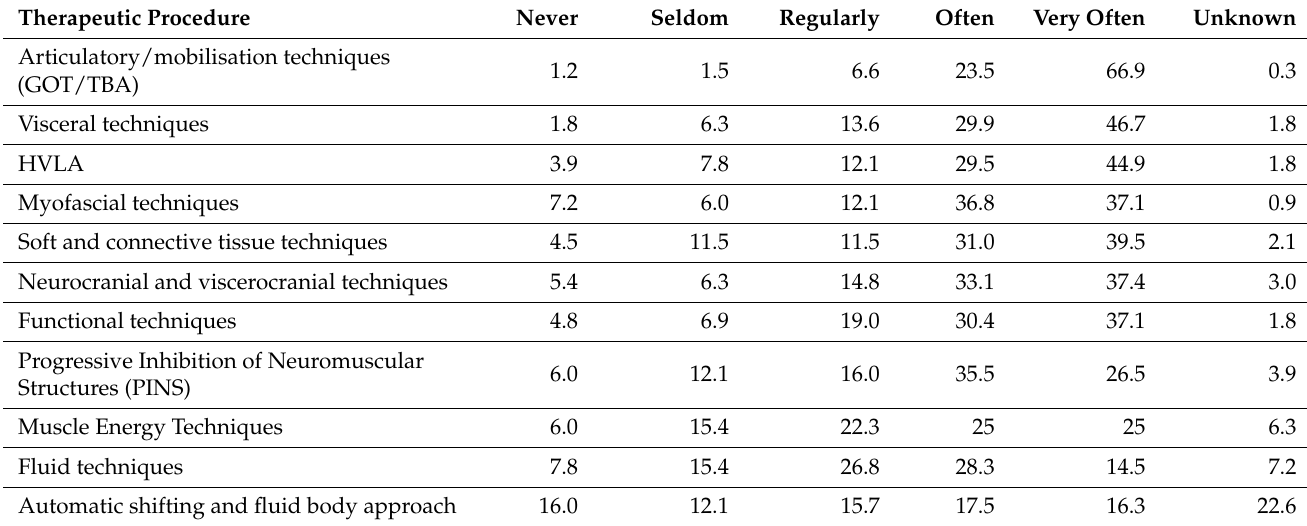
Table 6. The most common therapeutic procedures (in descending order of ‘often’ and ‘very often’